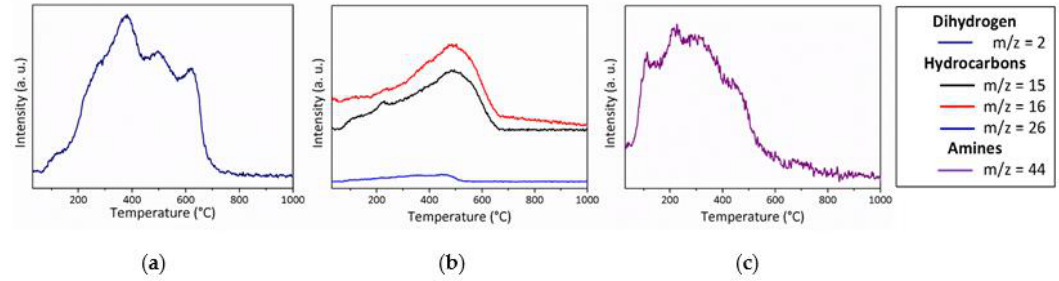
Figure 8. MS curves recorded during TG experiments of the PVMSZTi 2.5 sample in flowing nitrogen: dihydrogen ( a ), hydrocarbons ( b ) and amines ( c ).